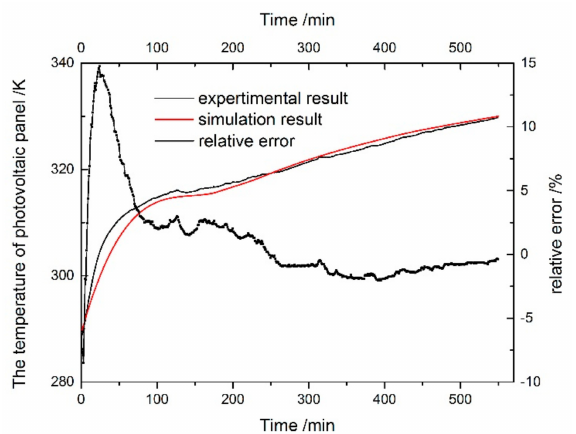
Figure 4. Temperature comparison of photovoltaic panel.